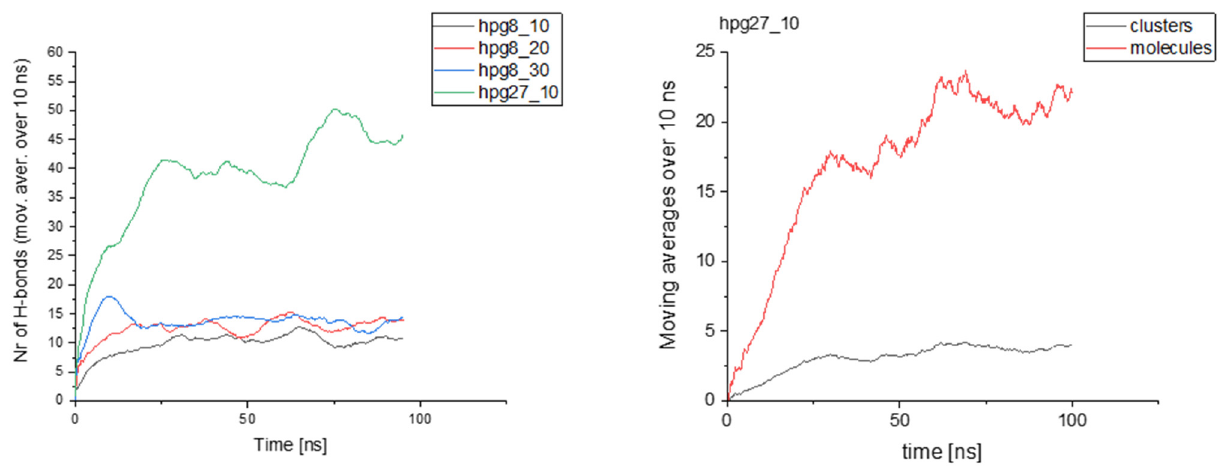
Figure 10. Left : Number of carvacrol–polymer hydrogen bonds with time in HPG systems. Right : Number of clusters (black) and number of carvacrol molecules found in clusters (red) in a 10:1 carvacrol–HPG 27-polymer-molecule system.